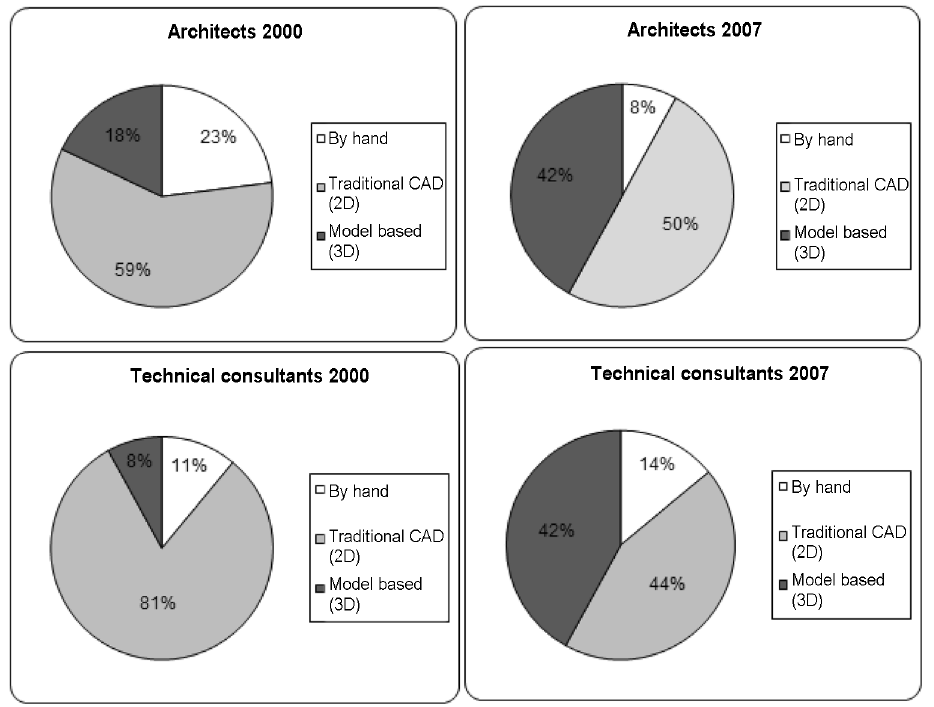
Fig. 3. Proportion of total time spent on design, where different tools have been used, 2000 and